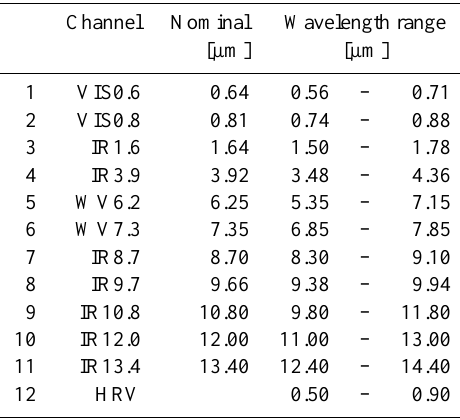
Table 1. MSG/SEVIRI spectral channels.